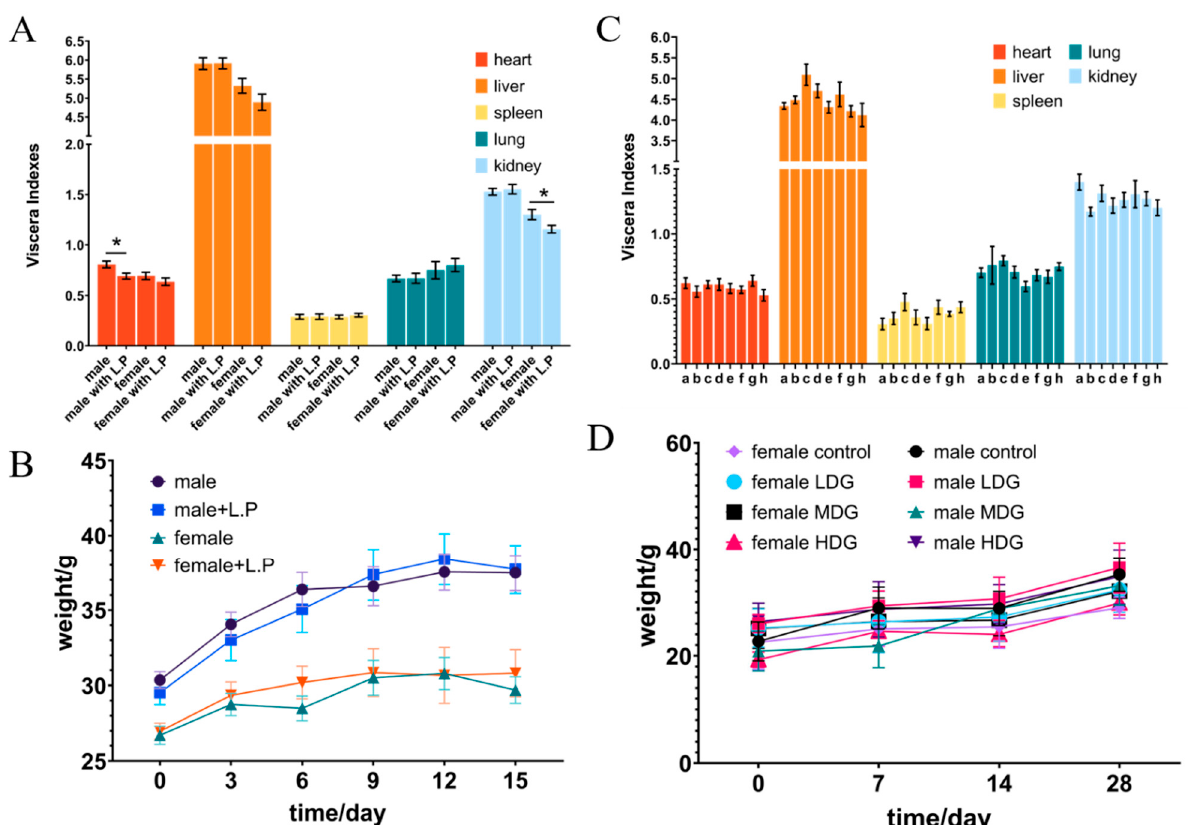
Figure 2. The changes in viscera index and body weight in mice administered with L. plantarum WYH by oral gavage for acute oral toxicity ( A , B ) and 28-day repeated toxicity ( C , D ). ( C ) a–d, respectively, represented normal saline (0), low concentration (10 8 ), medium concentration (10 9 ), and high concentration (10 10 ) feeding groups of male mice. Additionally, e–h had the same means in the female mice group. * p < 0.05.